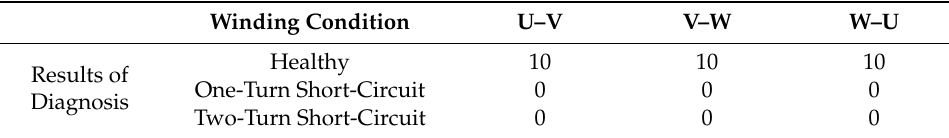
Table 9. Diagnostic results for the 2.2-kW motor 3